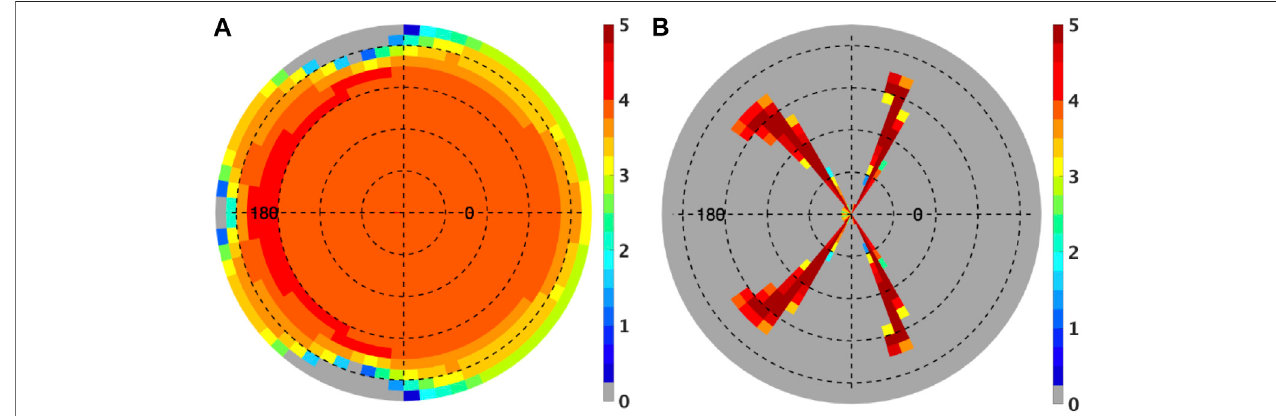
FIGURE7| Logarithmofsamplenumbersineach5 ◦ viewingzenithangleand5 ◦ relativeazimuthanglebinofallobservationswithin40 ◦ and50 ◦ solarzenithangles for the Aqua CERES instrument in RAP mode (A) and in cross track mode (B) using data of april 2004. Grey color indicates no observations.